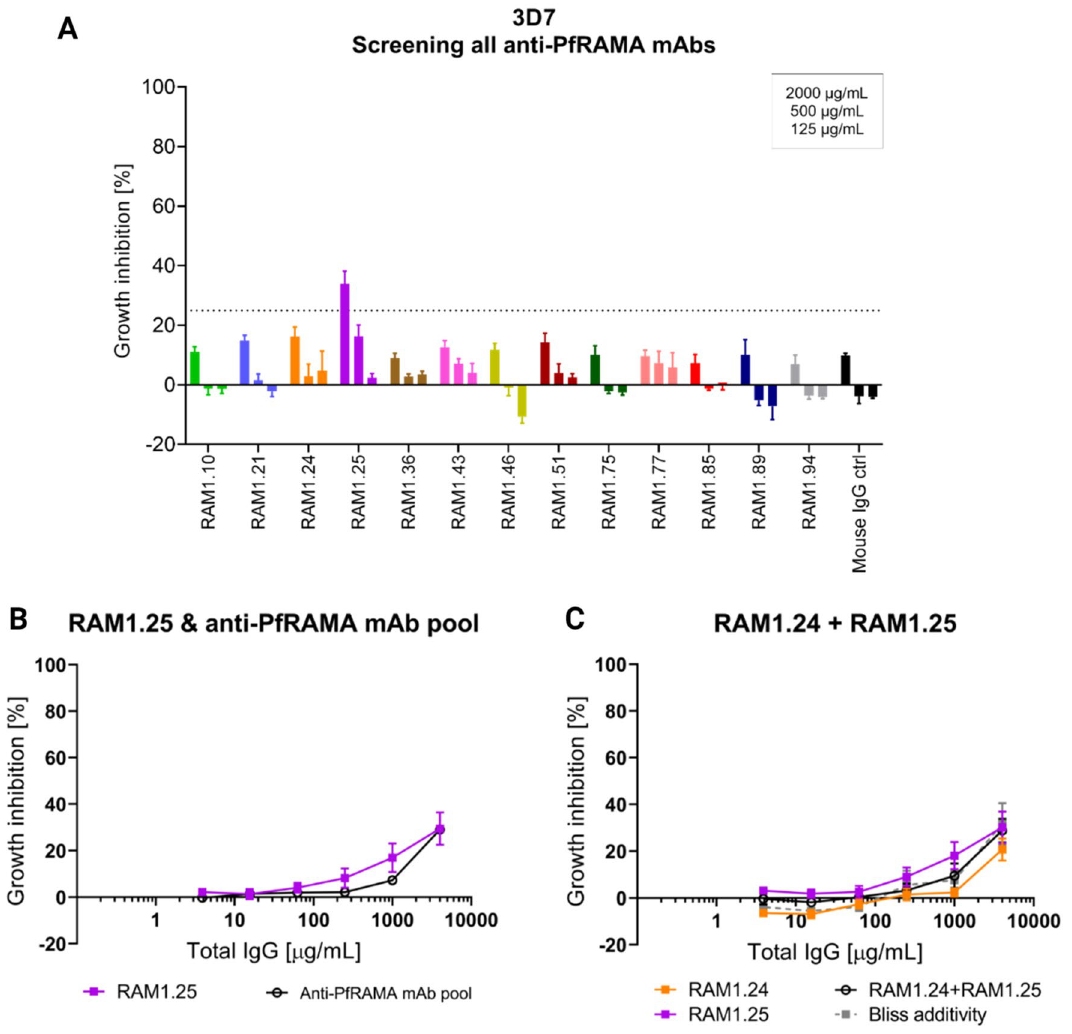
Figure 3. Growth inhibition activity of PfRAMA mAbs. (A) GIA assay using a panel of PfRAMA-specific mAbs screened at 2000, 500 and 125 µg/mL against P. falciparum 3D7 strain. A black dotted line shows a cut-off between mAbs inducing high GIA and mAbs inducing negligible GIA. (B) GIA assay using dilution series of RAM1.25 and a pool of 13 anti-PfRAMA mAbs, starting at 4000 µg/mL, against 3D7 parasites. (C) GIA assay using a dilution series of individual mAbs (RAM1.24 and RAM1.25) as well as in combination against 3D7 parasites, all starting at 4000 µg/mL. The predicted additive effect was calculated using the formula of Bliss additivity shown in the grey dotted line. The observed effect of combining the two anti-PfRAMA mAbs is shown in the black solid line. Error bars show SEM for six replicates over two